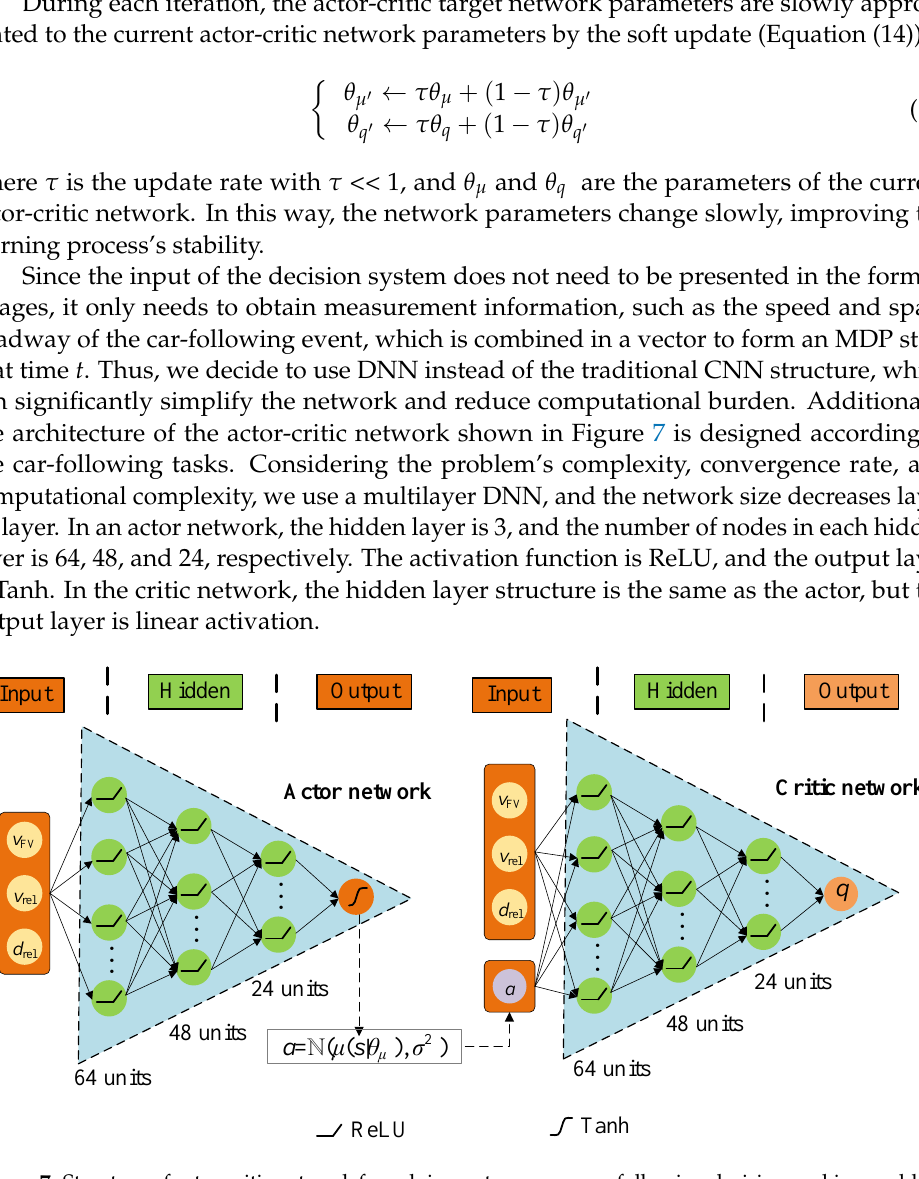
Table 2. Simulation parameter setting for autonomous car-following decision-making strategy.